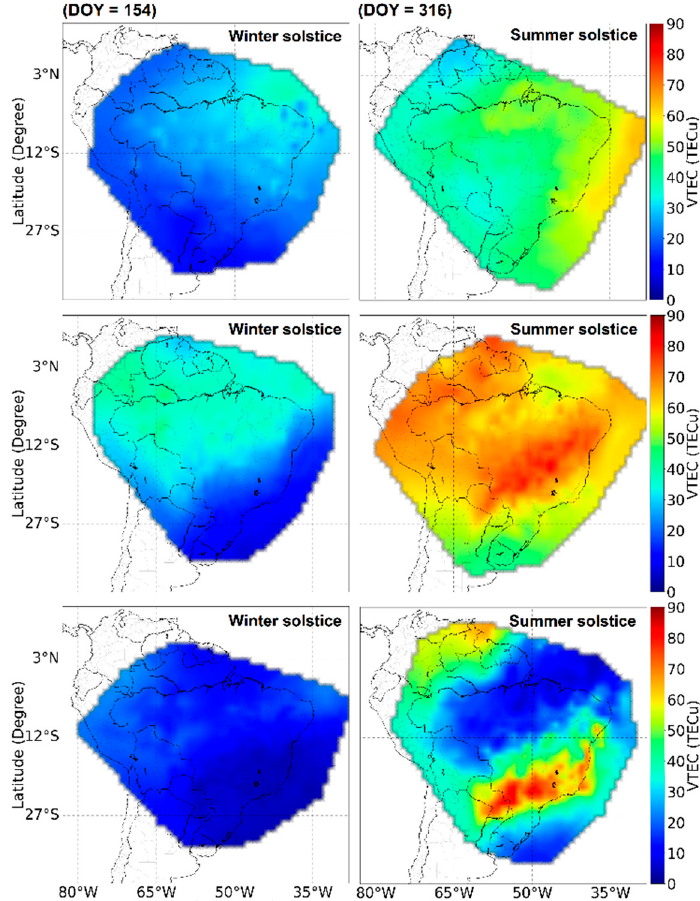
Figure 1. Example of TEC maps used as input to the neural network to be discussed in the later sections. Right / left panels —winter/summer solstice example (3 June and 20 November, respectively). Upper / middle / lower panels —TEC map at 13h00UT/20h00UT/23h00UT (morning/afternoon/early nighttime for the Brazilian region).